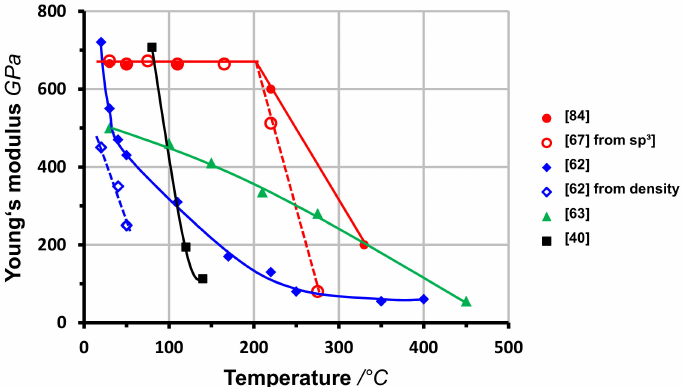
Figure 21. Dependence of the Young’s modulus (determined by laser acoustics) on the substrate temperature for carbon films prepared by vacuum arc deposition. Filtered dc arc deposition (mean ion energy 90 eV [67,84]), filtered anodic Laser-Arc deposition (biased substrates, 87 eV [40]), and unfiltered cathodic Laser-Arc deposition (grounded substrates, 80–90 eV [62], 48 eV [63]). Empty symbols denote the estimations from the sp 3 content [67] and from the density [62] according to Equations (2) and